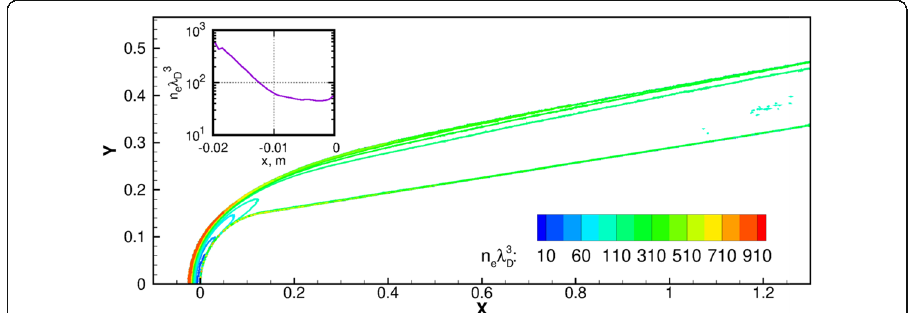
Fig. 8 Number of electrons in the Debye